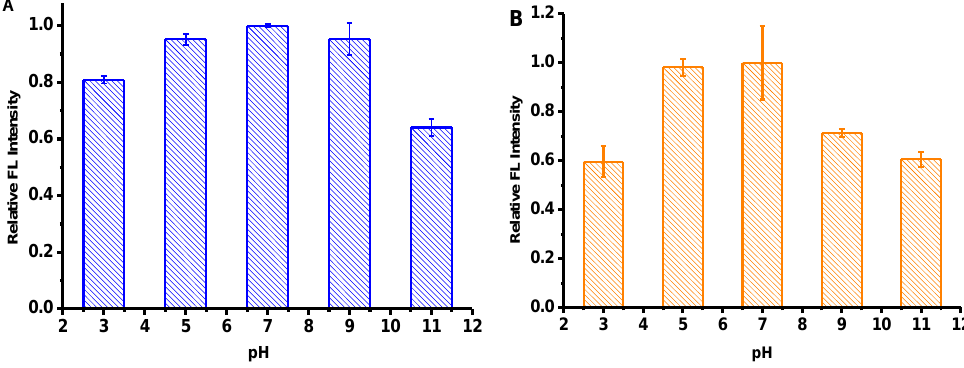
Figure 6. Effects of pH on the fluorescence (FL) intensity of the polysaccharide-based NSs derived from starch ( A ) and chitosan ( B ).